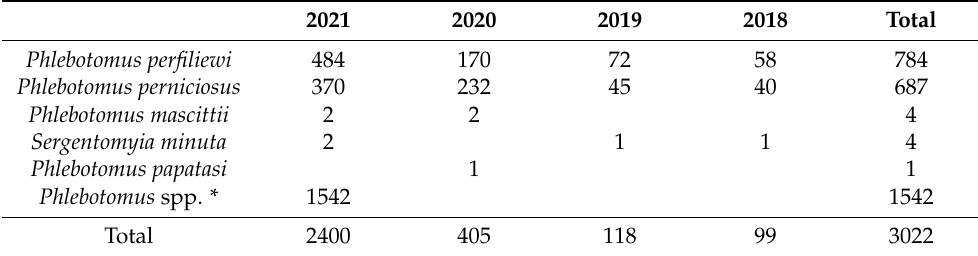
Table 1. Sand flies collected in the different years of sampling by specimens identified.